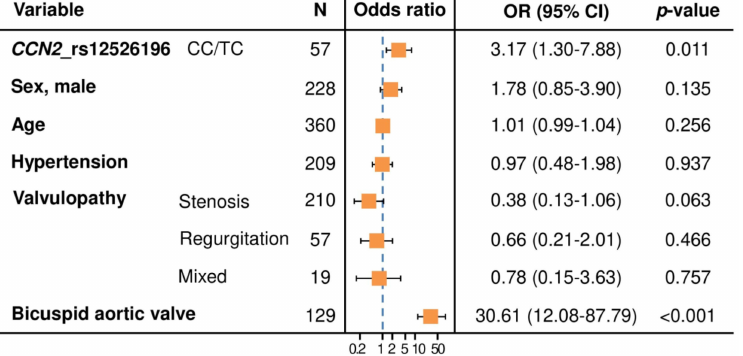
Figure 3. Forest plot showing the multivariable logistic regression model for the association between CCN2 rs12526196 polymorphism, under a dominant model of inheritance, and the presence of thoracic aortic aneurysm, adjusted for potential confounders. Reference for CCN2_rs12526196 polymorphism: TT genotype. Reference for sex: female. Reference for valvulopathy: normal functioning valve. Reference for bicuspid aortic valve: tricuspid aortic valve. N = number of patients. OR (95% CI): Odds ratio (95% confidence